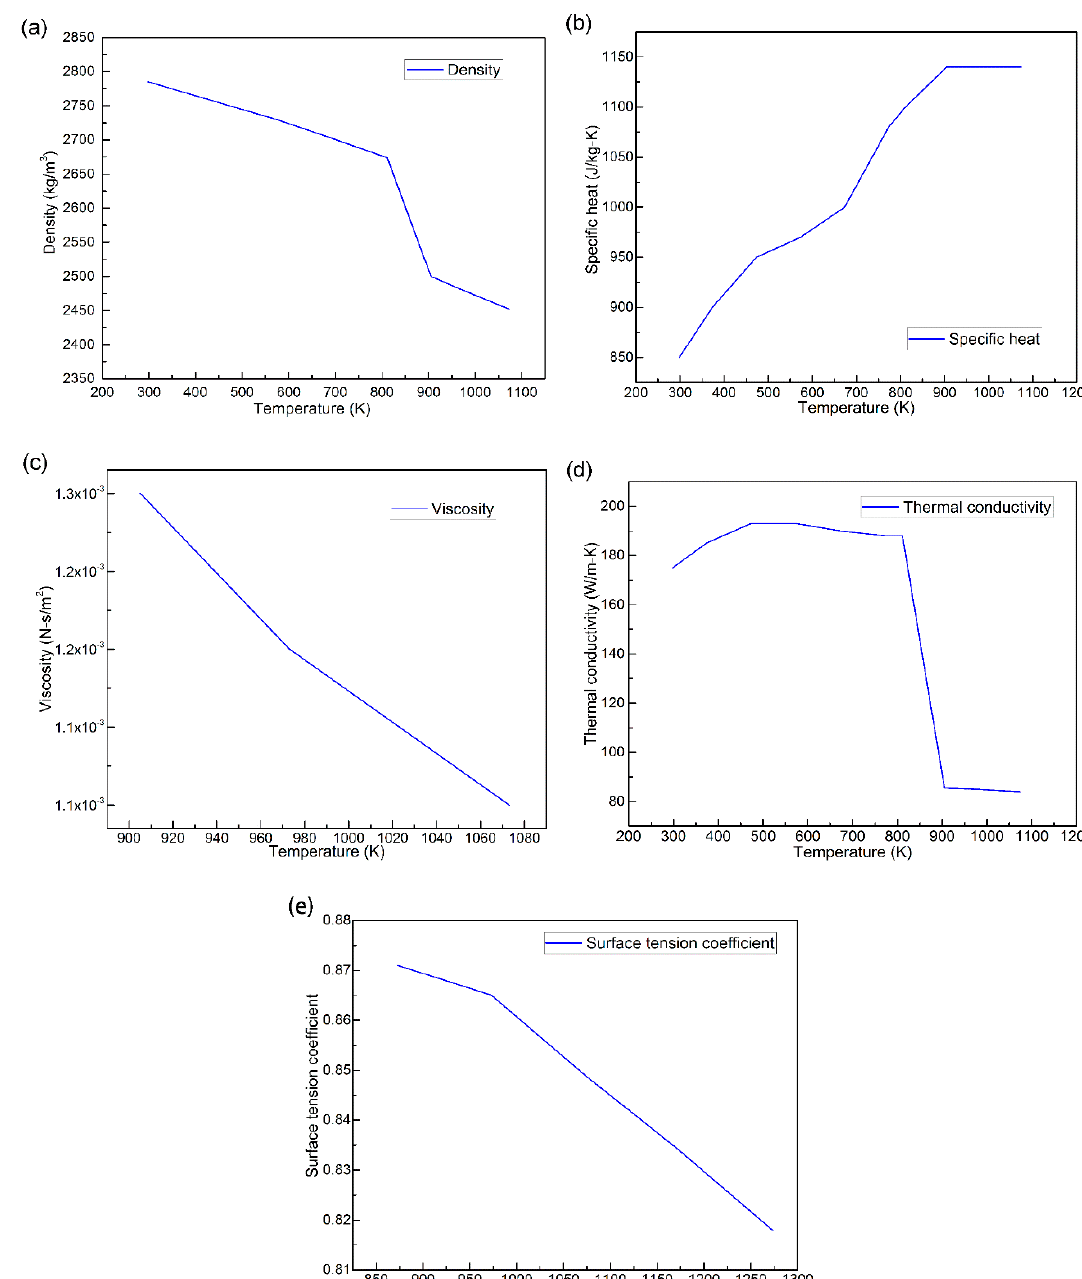
Figure 3. Temperature-dependent thermo-physical properties of 2024 aluminum alloy: ( a ) density, ( b ) specific heat, ( c ) viscosity, ( d ) thermal conductivity, and ( e ) surface tension coefficient.